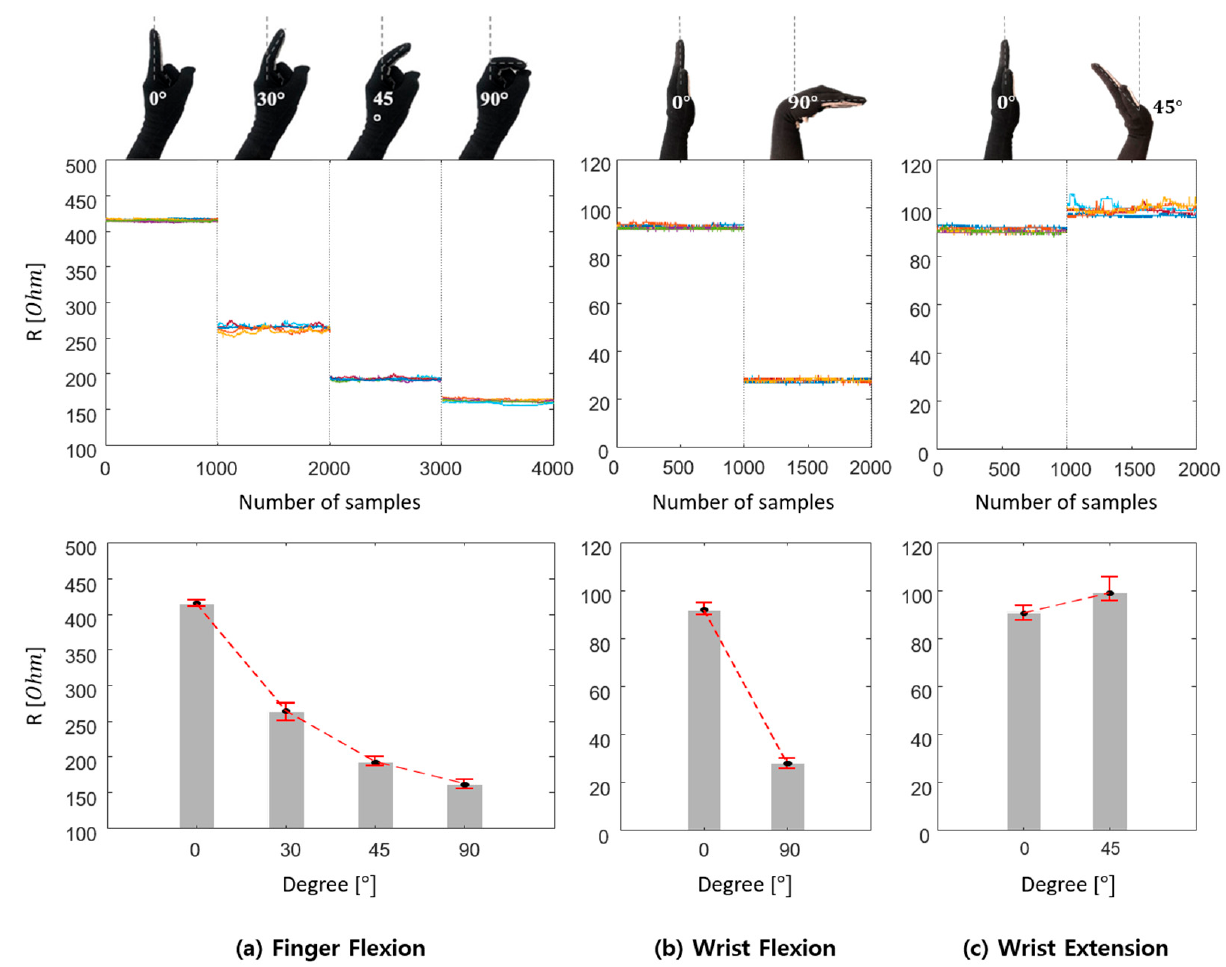
Figure 7. Strain characterization results of the knitted sensing glove: ( a ) index finger flexion; ( b ) wrist flexion; ( c ) wrist extension.